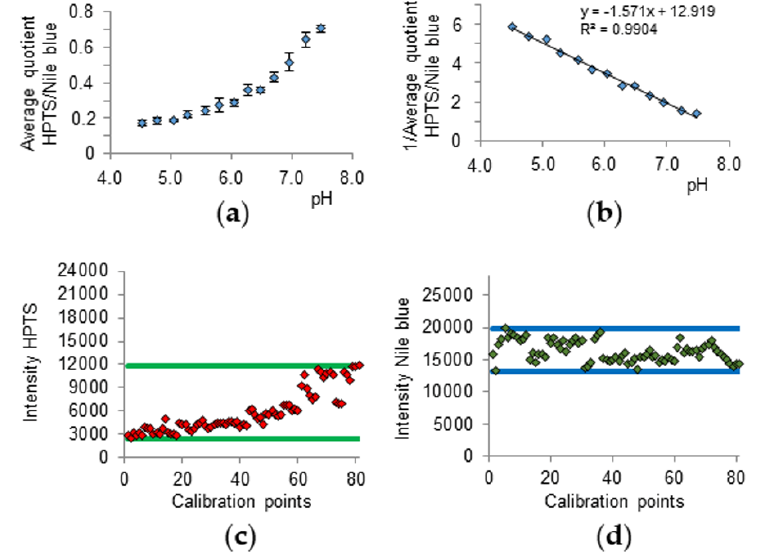
Figure 2. Average quotient of HPTS and Nile blue emission ( a ) its calibration ( b ), HPTS emission intensity raw data points of the calibration ( c ), and Nile blue emission intensity raw data points of the calibration ( d ). Error bars in ( a ) represent the standard deviation of the measurements of three single beads.